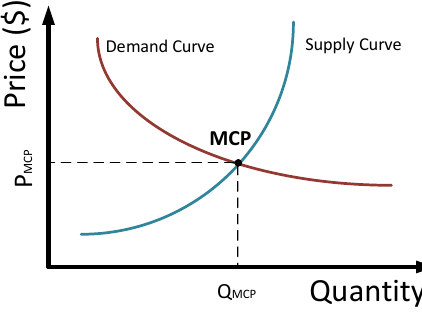
Figure 6. The schematic diagram of Market Clearing Price